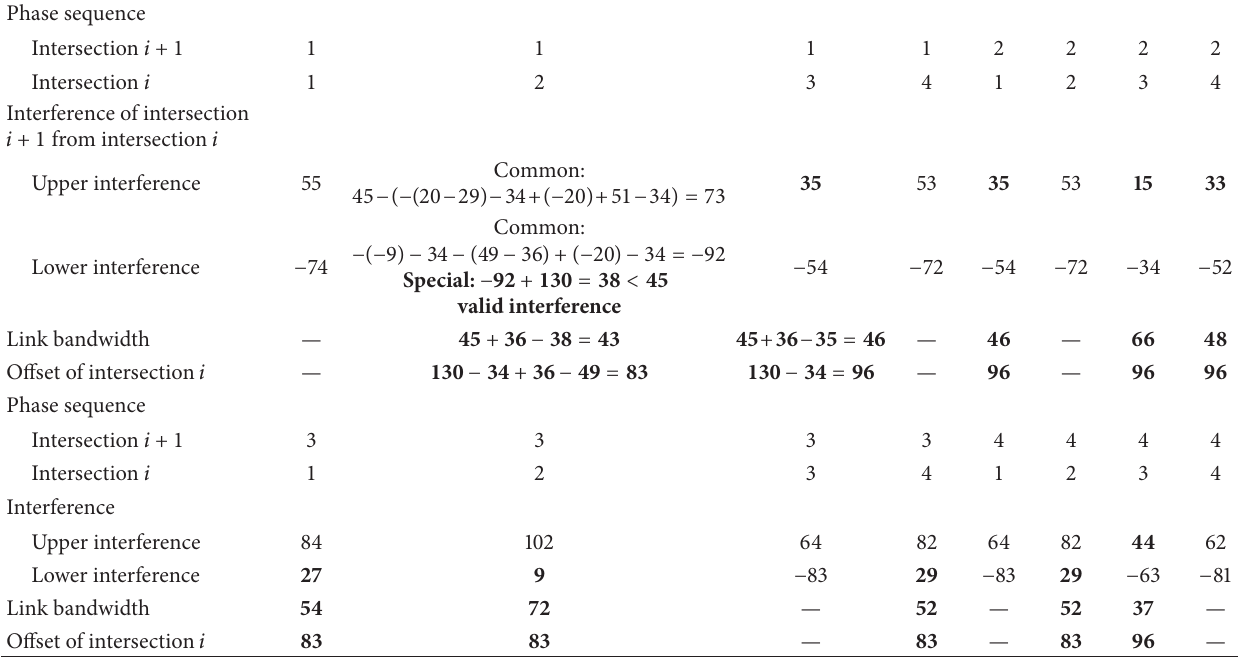
Table 3: Upper/lower interferences of two consecutive intersections.